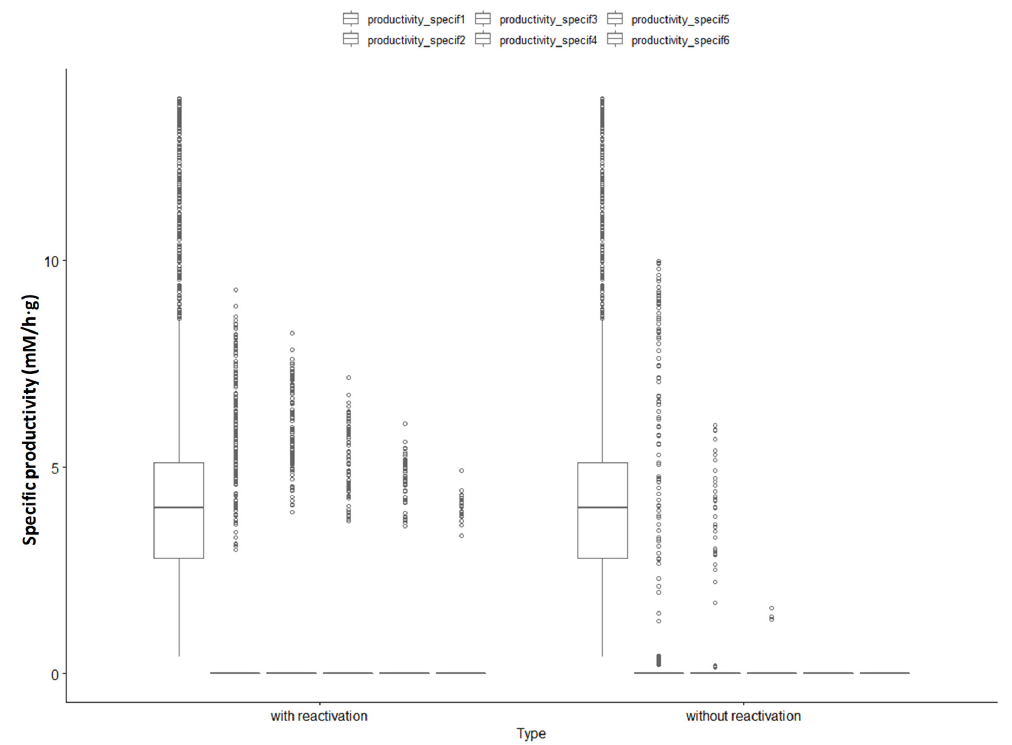
Figure 10. Specific productivity per batch with and without inactivation.